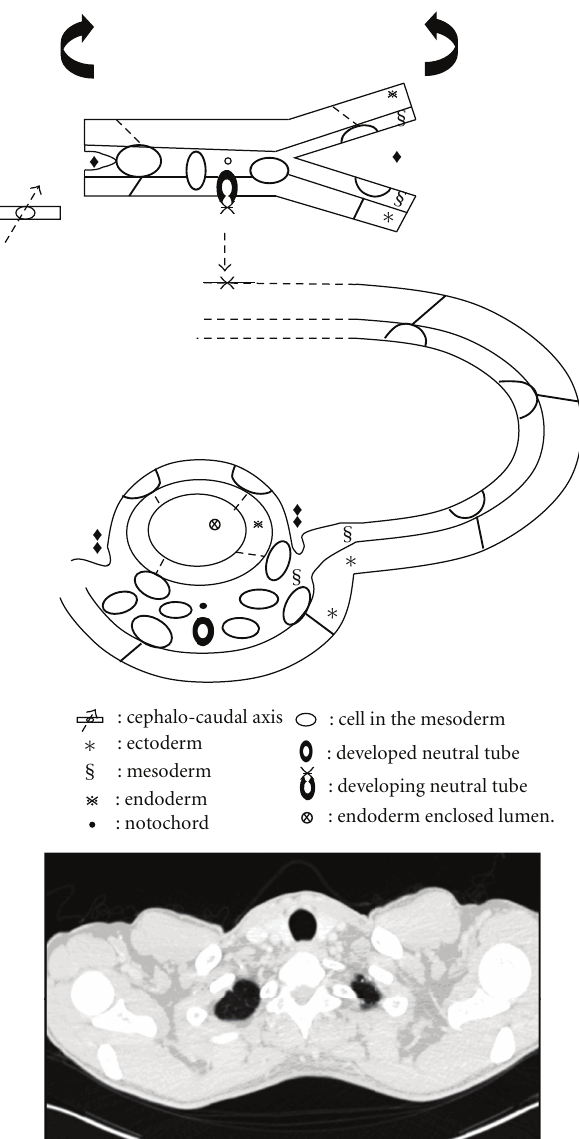
Figure 5: Body cavity formation. Diagram shows the mesoderm splits into parietal and visceral layer, which forms the intraembry- onic coelomic cavity. The intraembryonic coelomic cavity is the primitive form of the body